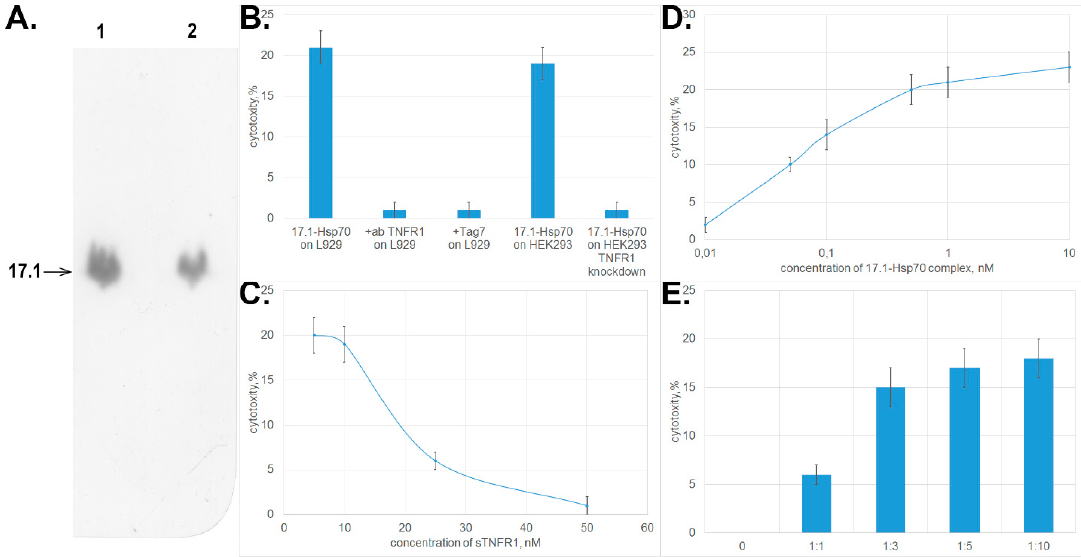
Figure 4. The complex formed between peptide 17.1 and Hsp70 causes tumor cell death. ( A ) Western blot showing 17.1 peptide binding to Hsp70. (1) control 17.1 peptide, (2) eluate of 17.1 from the column